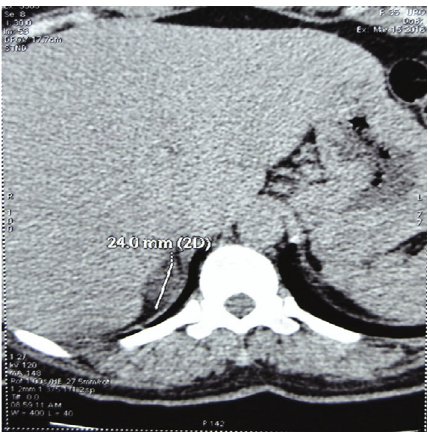
Figure 1: Right adrenal mass in the women.